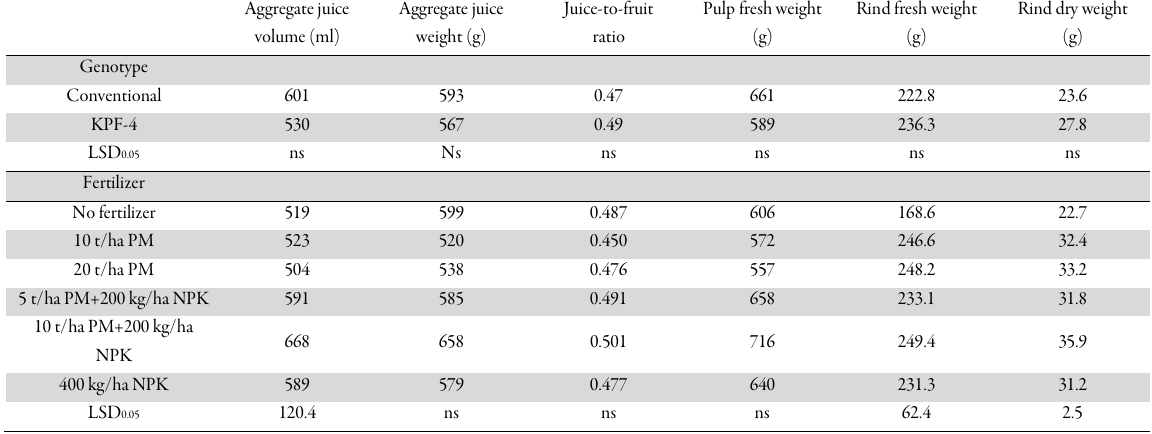
Table 7. Main effects of genotype and fertilizer on some fruit and juice metric traits of yellow passion fruit grown in the field in 2017